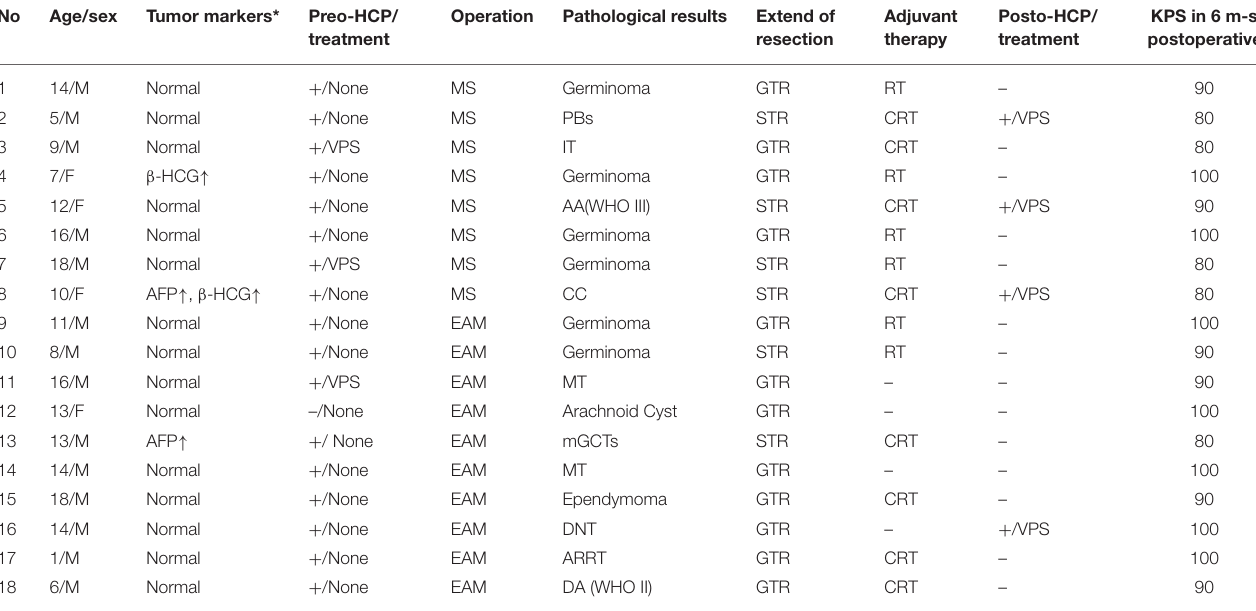
TABLE 1 | Summary of cases in our